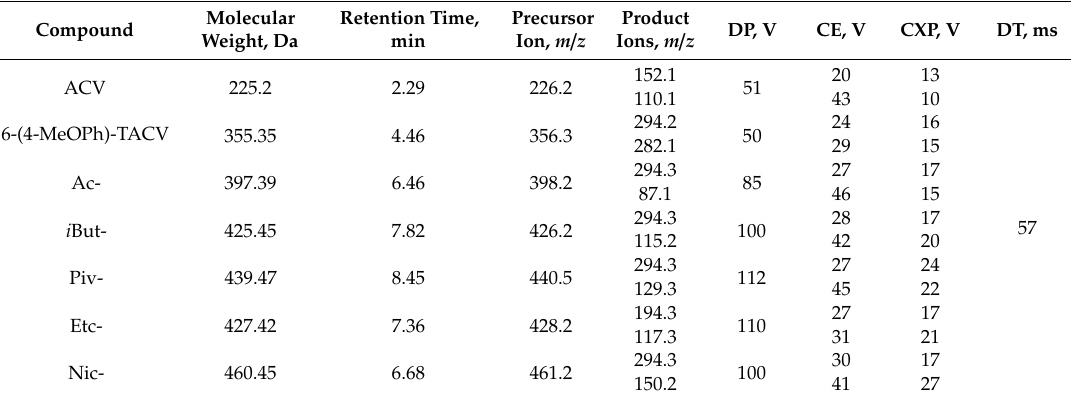
Table 6. Parameters optimized for the MS / MS